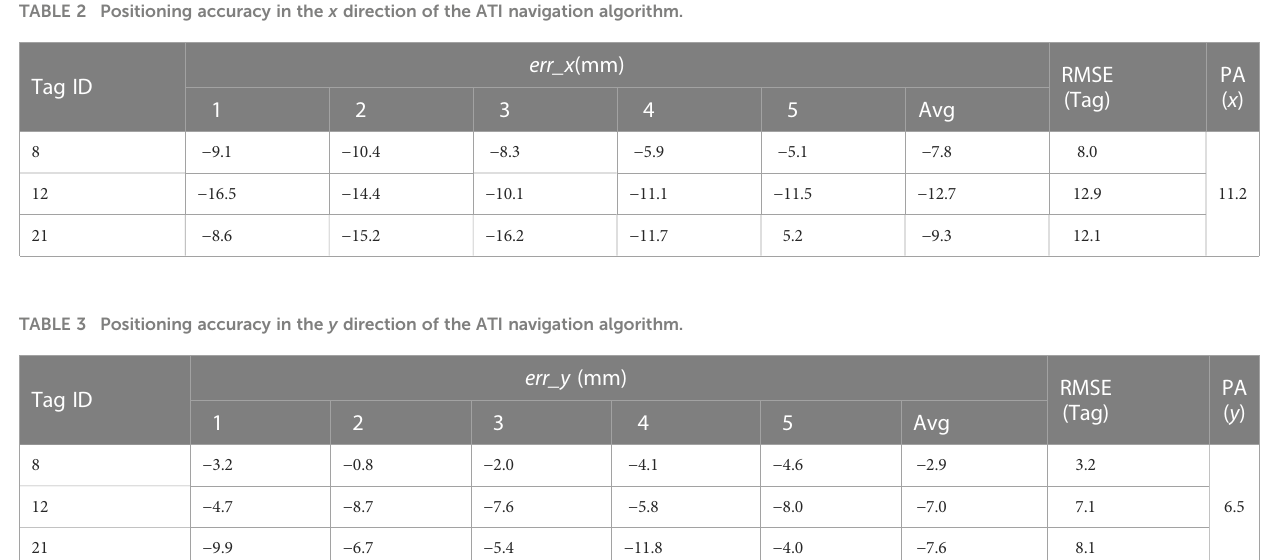
TABLE 2 Positioning accuracy in the x direction of the ATI navigation algorithm.